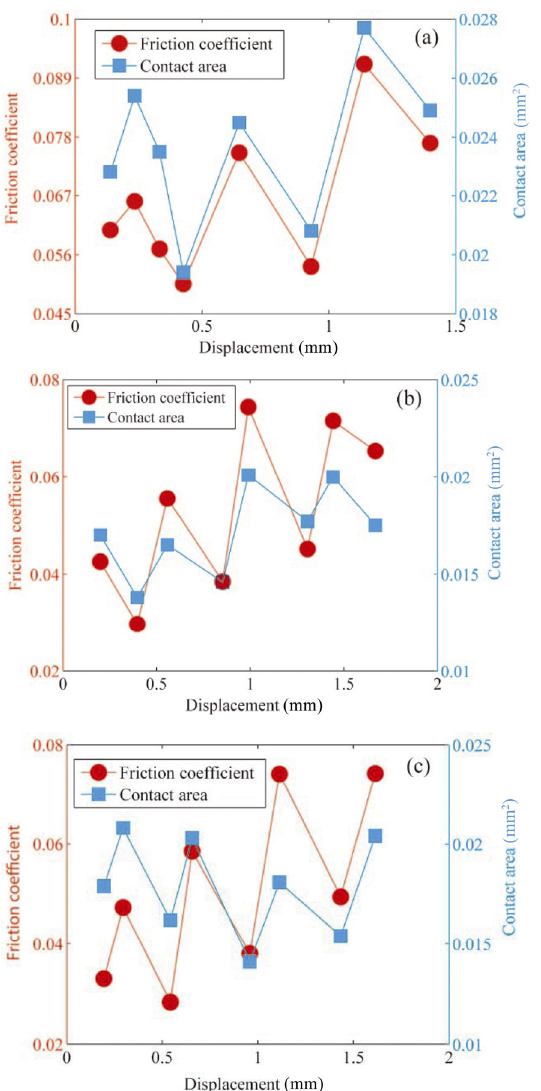
Fig. 9 Correspondence between the friction coefficient and contact area under a load of 3 N and velocities of (a)